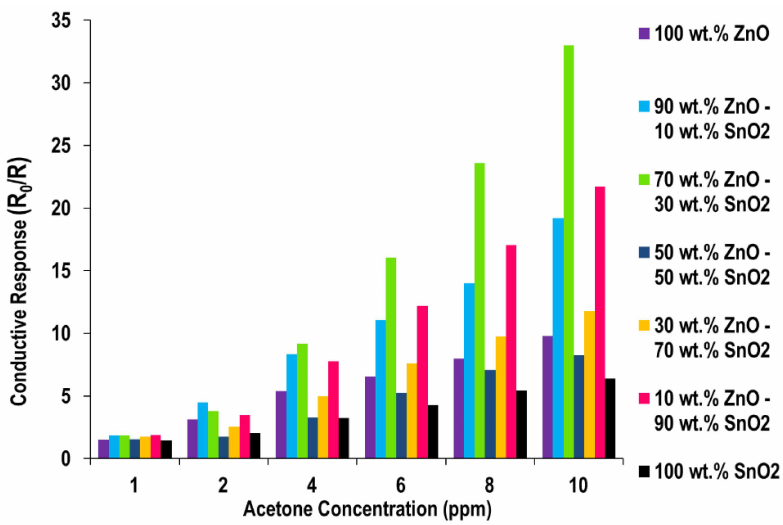
Figure 10. Conductive responses of SnO 2 -ZnO array towards 1, 2, 4, 6, 8 and 10 ppm acetone gas, at an operating temperature of 300 ˝ C. The best response of 34 is observed for the 70 wt% ZnO:30 wt% SnO 2 device on exposure to 10 ppm of